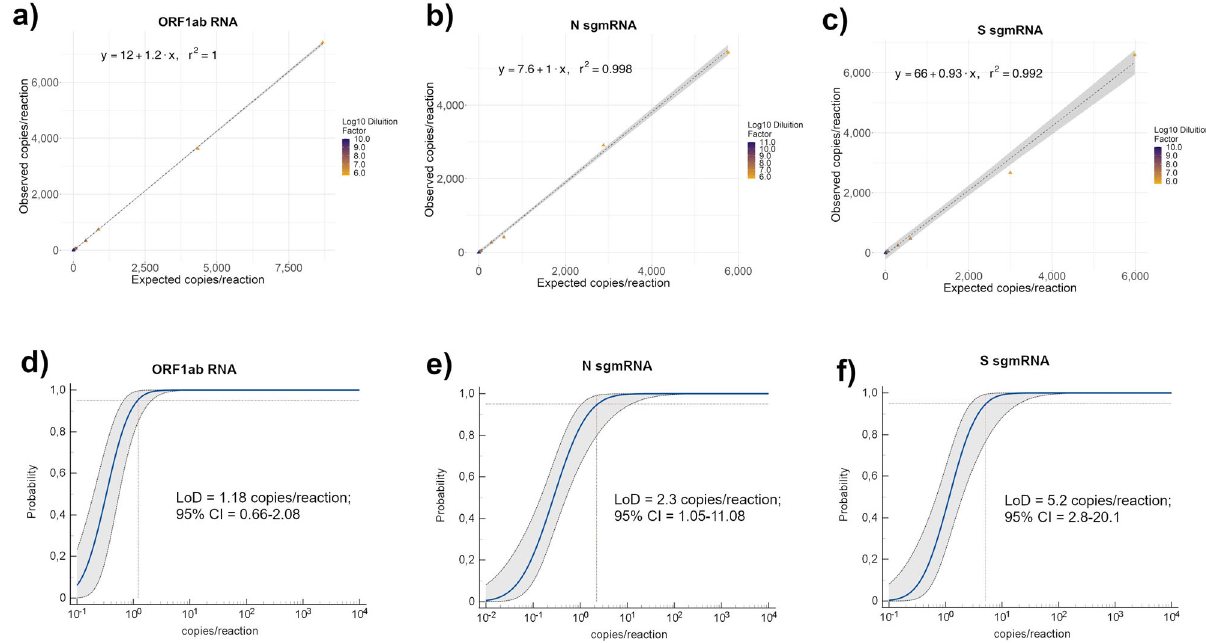
Fig. 1 Accuracy and Limit of detection (LoD) of SARS-CoV-2 genomic ORF1ab RNA and N and S sub-genomic RNAs by ddPCR assays. a – c Accuracy of designed SARS-CoV-2 ddPCR assays was evaluated using ten serial dilutions, each with at least nine replicates, performed on custom synthetic DNA sequences corresponding to portions of ORF1ab RNA and N and S sgmRNAs. Accuracy was evaluated by linear regression analysis plotting expected ( Y - axis) vs ddPCR observed ( X -axis) copies per reaction for ORF1ab RNA ( a ), N sgmRNA ( b ) and S sgmRNA ( c ). The regression equation and R 2 are shown in the top corner. The gray area represents a 0.95 level of con fi dence interval. d – f Limit of detection (LoD) of designed SARS-CoV-2 ddPCR assays was evaluated on the same serial dilutions of custom synthetic DNA sequences corresponding to portions of ORF1ab RNA and N and S sgmRNAs, used for the accuracy analysis. LoD for ORF1ab ( d ), N sgmRNA ( e ), and S sgmRNA ( f ) was de fi ned by probit analysis using MedCalc